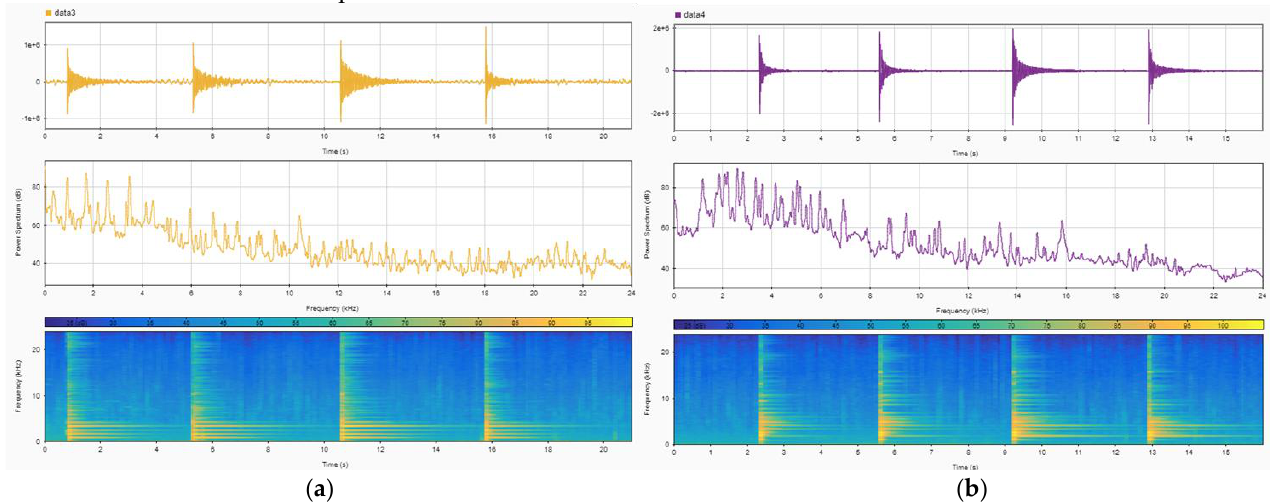
Figure 4. Railway wheelsets ( a ) excitation in horizontal direction); ( b ) excitation in vertical direction). I — impact sound (Sound pressure versus Time), II — Frequency spectrum (Sound pressure level versus Frequency), and III — spectrogram (Frequency versus Time versus Sound pressure level (color)).